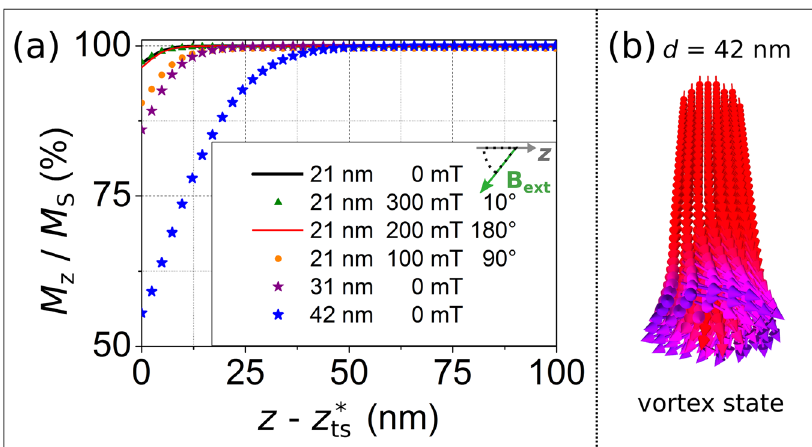
Fig. 5 Micromagnetic simulations of the internal iron nanowire magnetization. a Simulated internal iron nanowire (FeNW) magnetization component M = M ’ free end at distance z (cid:4) z (cid:2) from the free end for three different iron NW diameters (21, 31, and 42 nm) and for several external fi eld z S near the NWs ts values and directions. M z = M S is averaged over the circular NW cross section area. b Vortex state in zero- fi eld with whirling magnetic moments close to the free end of a d = 42 nm FeNW.